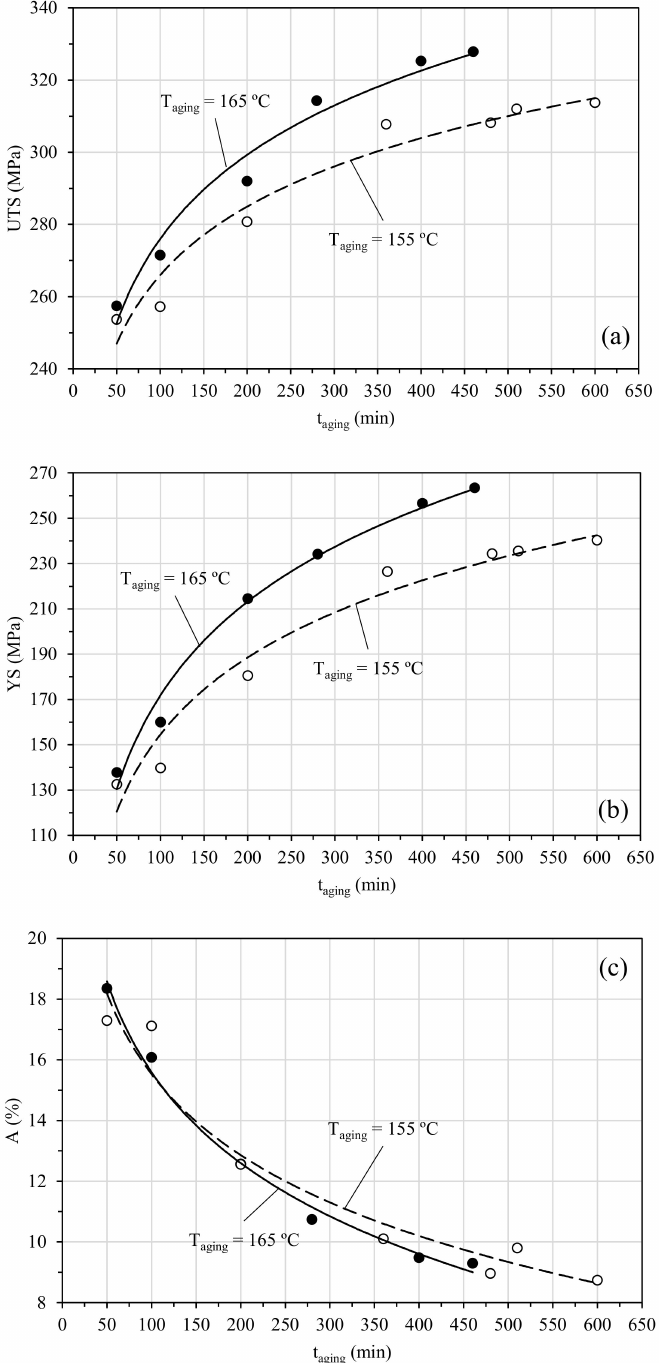
Figure 13. Evolution of UTS ( a ), YS ( b ) and A ( c ) with aging time in castings TA at 165 ◦ C (solid circles) and at 155 ◦ C (open circles). Best least square fits are plotted as a solid line and as an interrupted line for T aging = 165 ◦ C and 155 ◦ C,